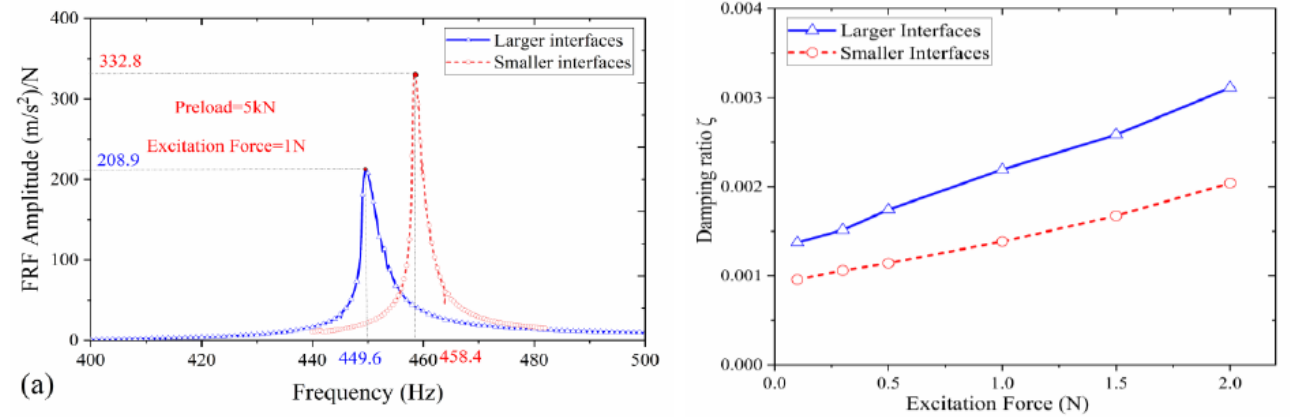
Figure 23. Results for different hole size, ( a ) FRFs curves, ( b ) modal damping ratio.